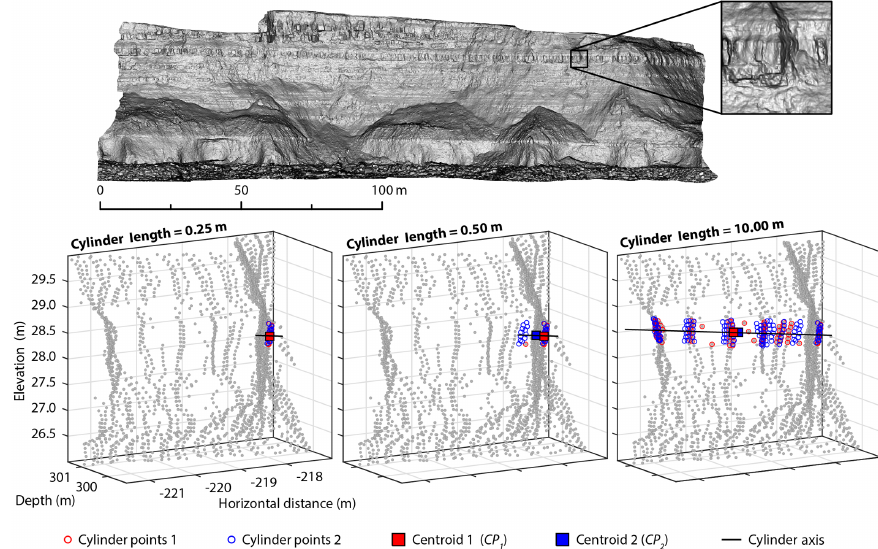
Figure 8. Inputs used for distance estimation with varying cylinder lengths. No appreciable change occurred between these two scans. As the cylinder length increases (from 0.25 to 0.50 to 10m), the number of surfaces that the cylinder intersects increases (direction equal to the normal vector). All points within a 0.25m radius would be included as cylinder points (circles) and the distance between their mean positions (squares) calculated. From top to bottom, this distance is 0.0011 to − 0.1460 to 0.0938m. Longer cylinders intersect multiple surfaces and therefore measure the distance between projected centroids that do not accurately represent the surface to which the query point belongs.